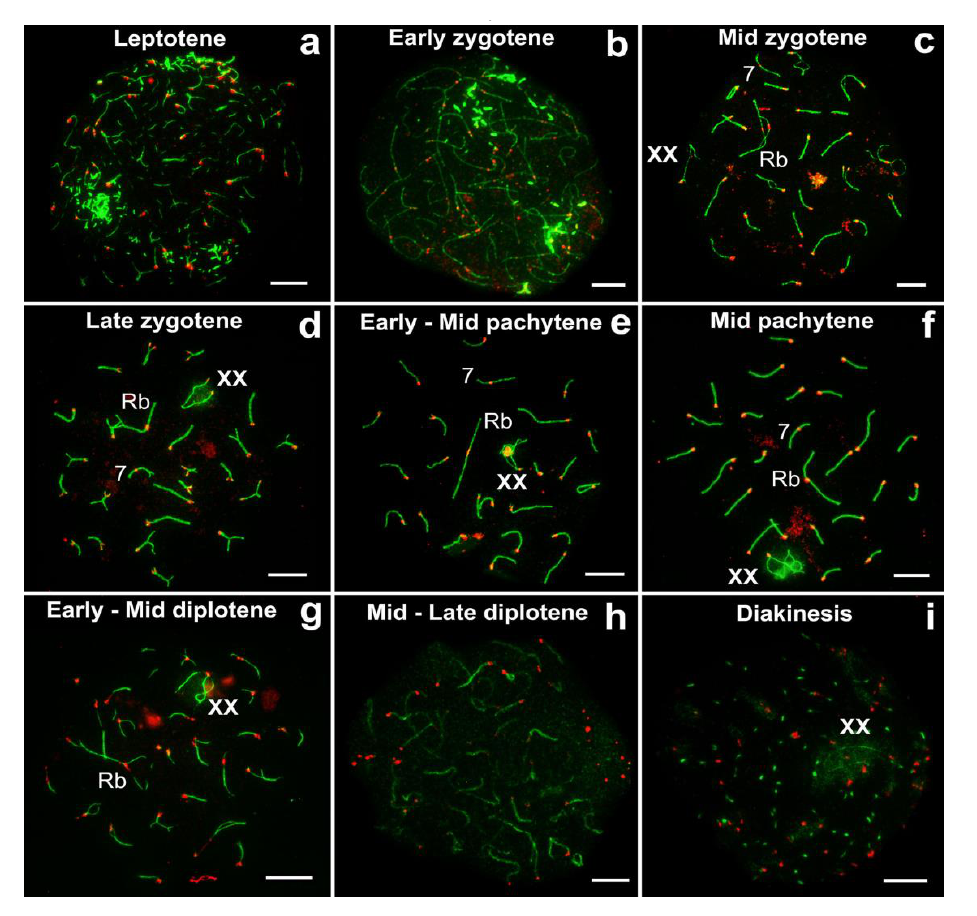
Figure 2. Prophase I stages in E. alaicus males. Axial/lateral elements were identified using anti-SYCP3 antibodies (green) and kinetochores (red) using CREST. During the leptotene stage, numerous thin SYCP3 fragments and SYCP3 conglomerates were formed ( a ), formed axial elements ( b ) were visible in the zygotene. Chromosome synapsis began with either distal (telomeric) ( c ) or central chromosome parts ( d ). At the pachytene stage, 25 autosomal SCs and sex (XX) bivalents were formed ( e , f ). The XX bivalent demonstrated synapsis at telomeric areas and asynapsis at the central region ( e , f ). In the mid-late diplotene, desynapsis progressed from both the central and telomeric areas ( g ). SYCP3 was degraded ( h ) and retained as dots ( i ). Rb—Robertsonian submetacentric. Chromosome 7 is non-Robertsonian submetacentric. Bar ( a – i ) = 5 µ